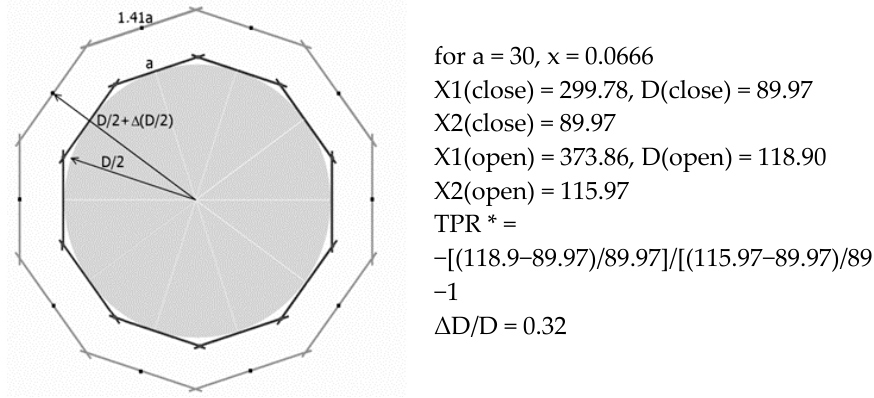
Figure 6. Schematic representation of a tubular structure built of 10 square frames times three rows in the closed position and in the open position, * Tube Poisson’s Ratio (TPR *) (with calculations). The square frames touch the circle line of the tubular structure with a D/2 radius.